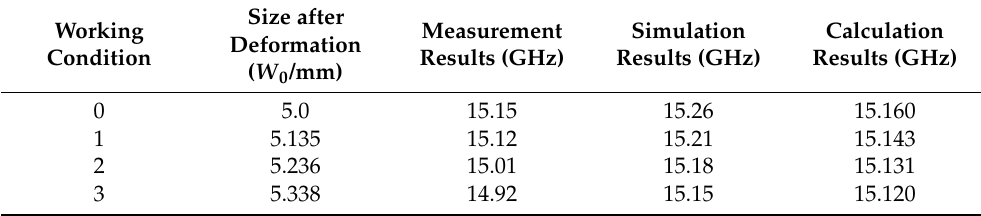
Figure 18. S11 curves of the Mode 2 antenna under four working conditions. ( a ) Working condition 0; ( b ) working condition 1; ( c ) working condition 2; ( d ) working condition 3. Table 14. Resonant frequencies of the Mode 1 antenna under four working conditions.